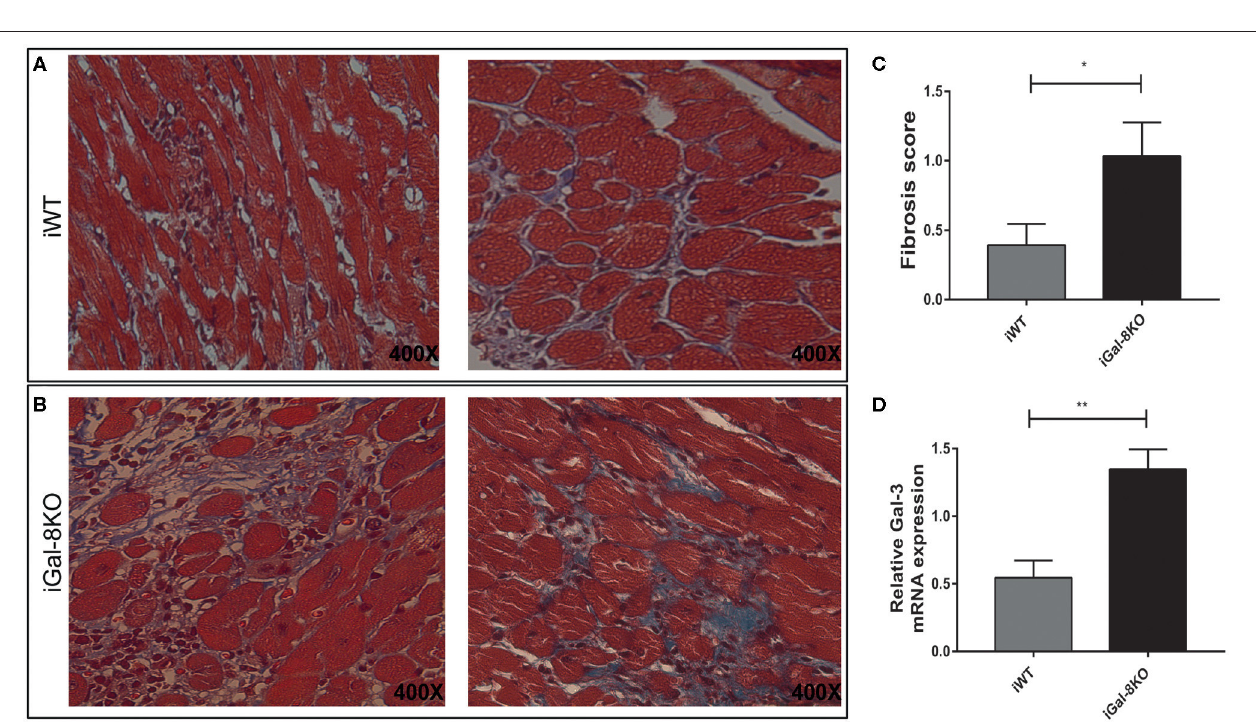
FIGURE 2 | Tissue parasite burden in Trypanosoma cruzi -infected Gal-8KO and wild-type (WT) mice. Parasite load was determined by real-time PCR normalized to host tumor necrosis factor (TNF) in mouse tissues at 4–5 mpi. Results are expressed as mean ± SEM of parasite DNA equivalents of at least three independent experiments (5 animals/group).